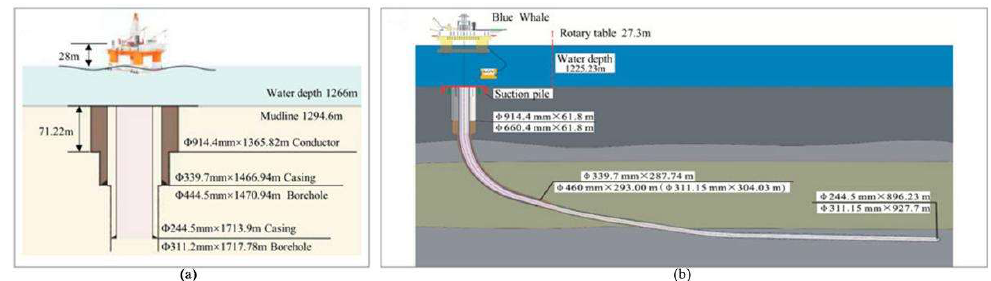
Figure 1. Schematic diagram of marine NGH exploitation: ( a ) the first marine production test in China and ( b ) the second first marine production test in China [55].